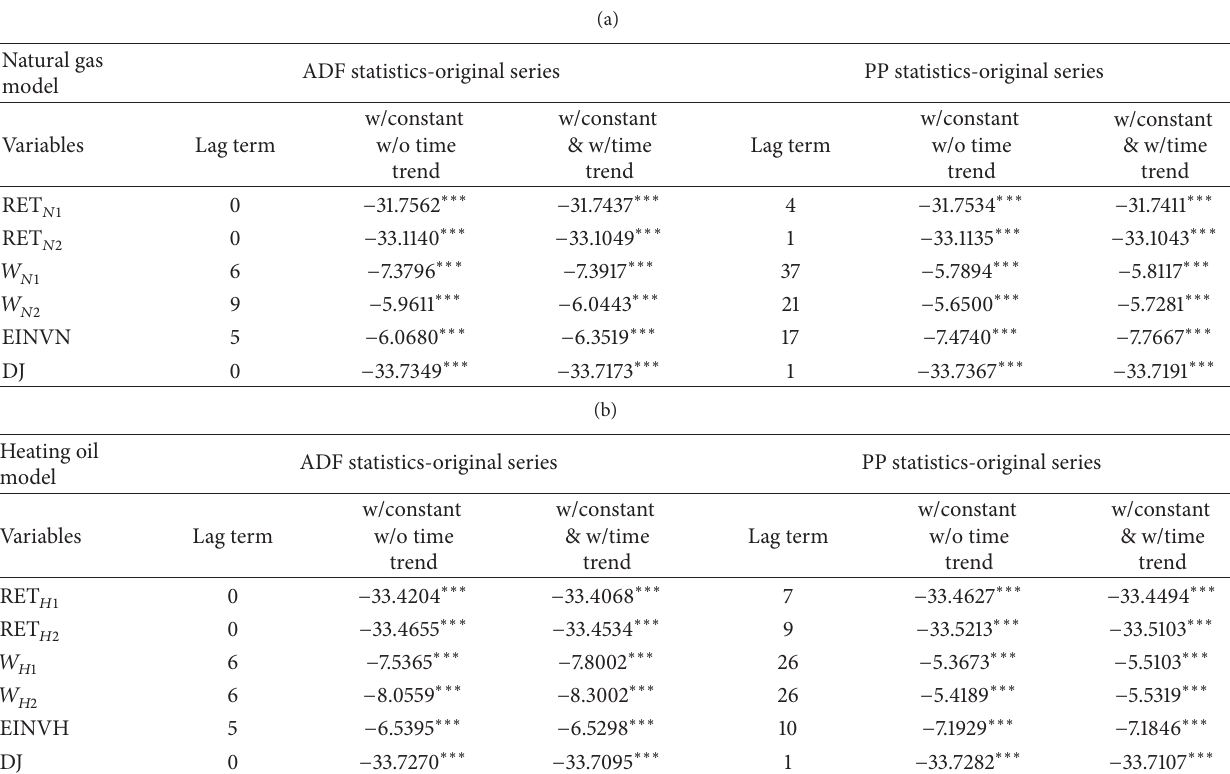
Table 1: Results for ADF